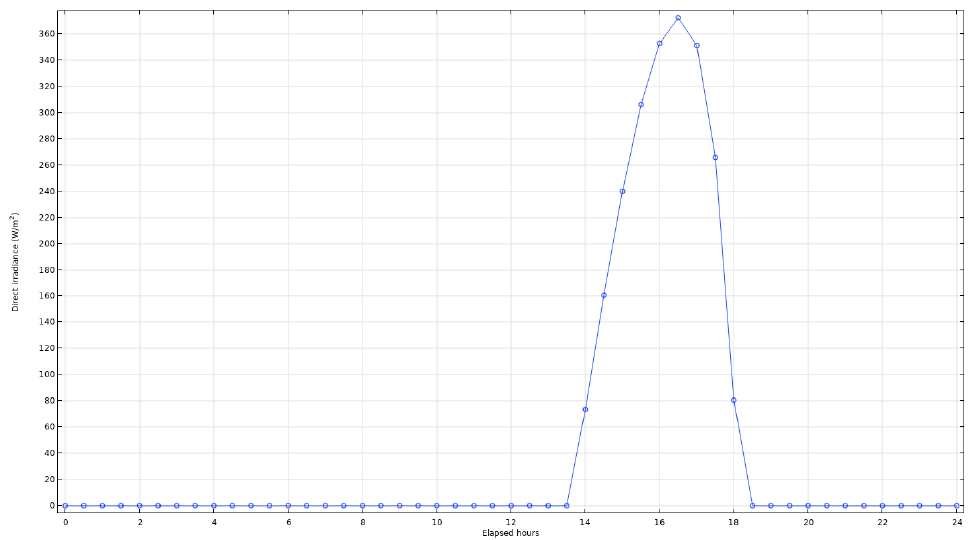
Figure 13. Direct Irradiance (Wm − 2 ) received by the cell at 2019’s winter solstice, referent to the boom’s west sides.